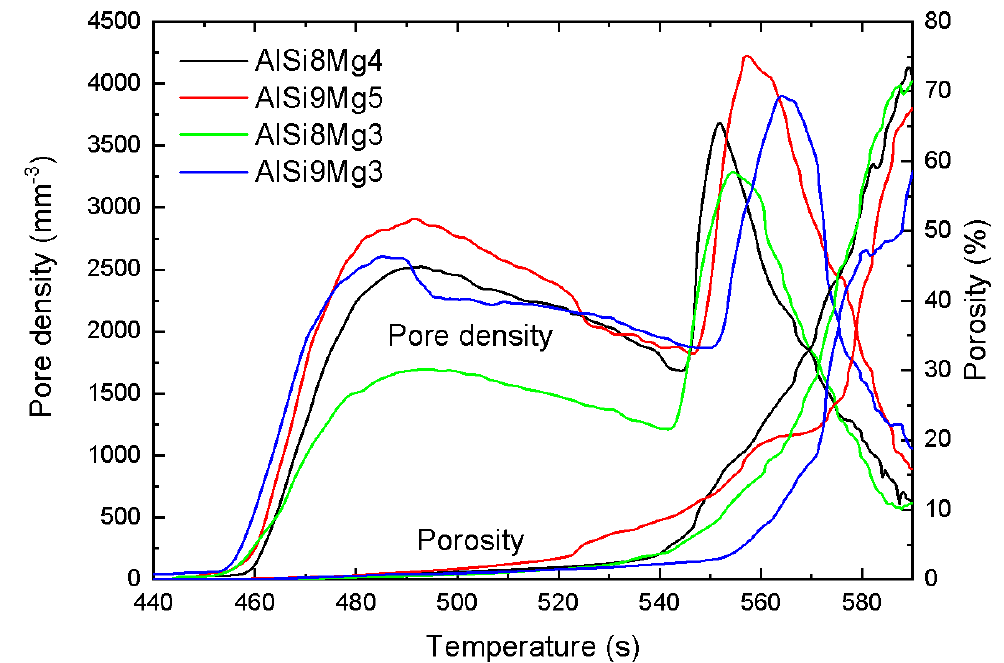
Figure B1. Pore density and porosity for selected samples of different alloy compositions over temperature corresponding to the samples shown in Figure 2.